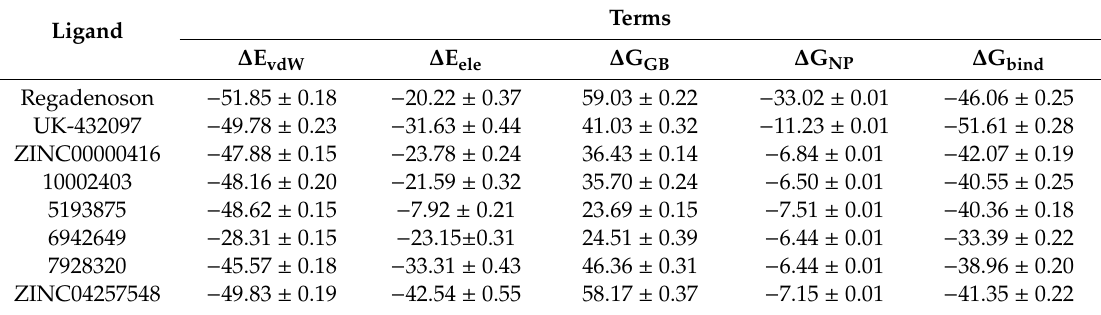
Table 11. A ffi nity energy values and energy components. ∆ E vdW , Van der Waals contributions; ∆ E ele , electrostatic contributions; a ffi nity